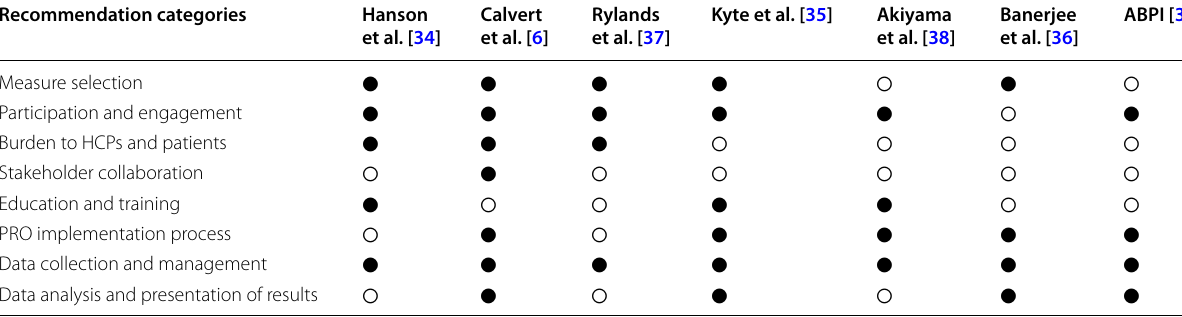
● Includes, ○ Does not